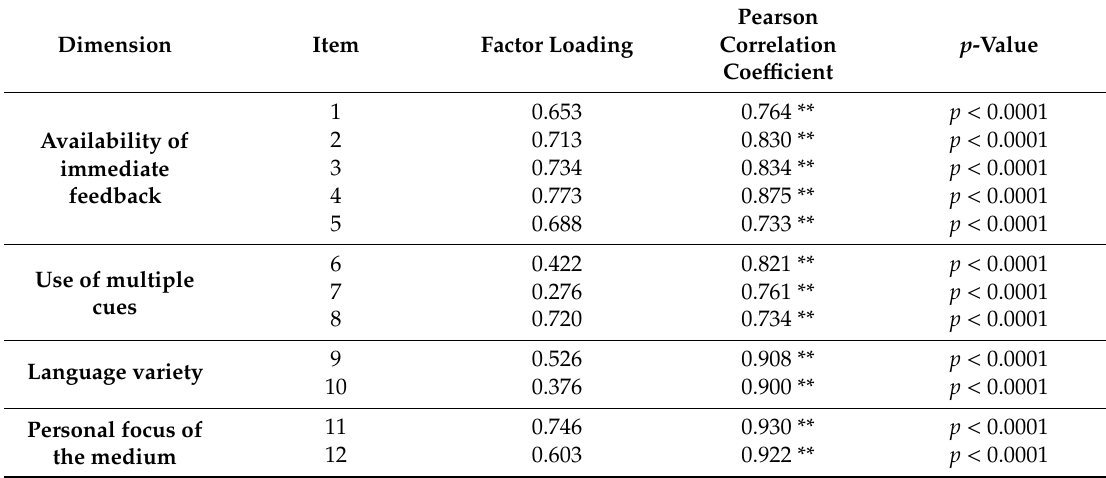
Table 5. The questionnaire validity of media richness.